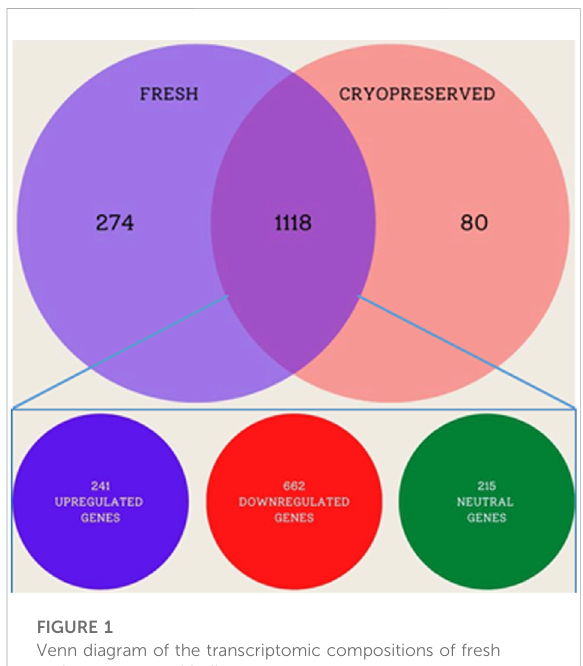
Venn diagram of the transcriptomic compositions of fresh and cryopreserved bull spermatozoa.